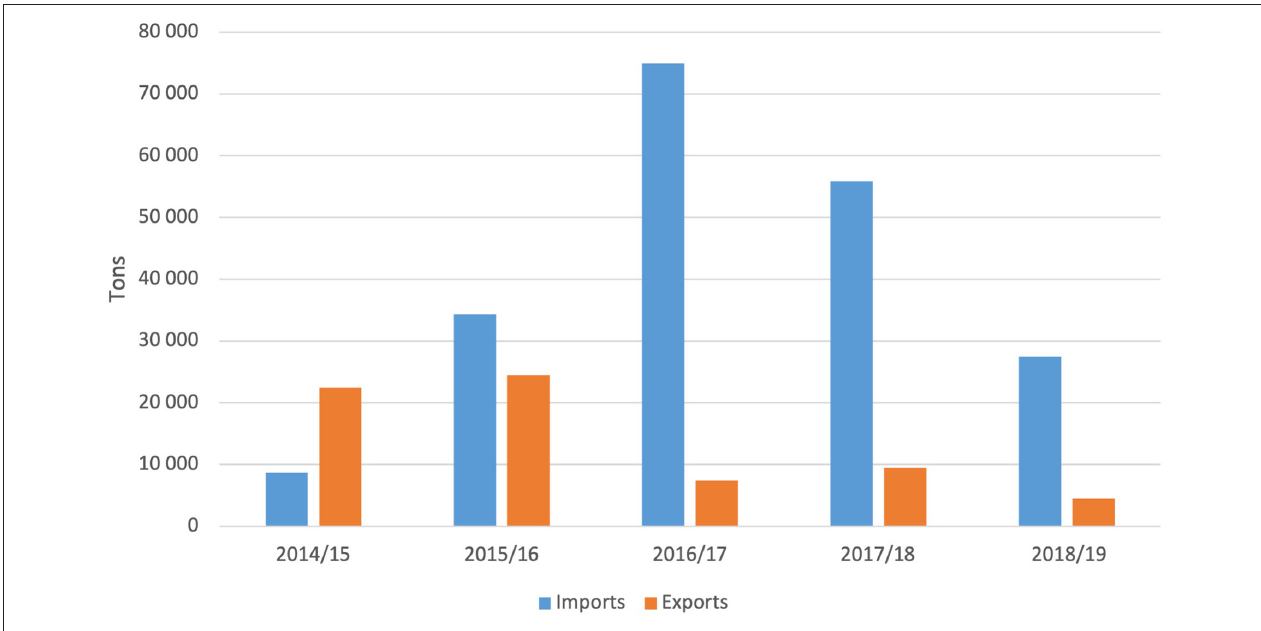
FIGURE 2 | South African sorghum imports and exports 2014–2018 (Source: SAGIS).